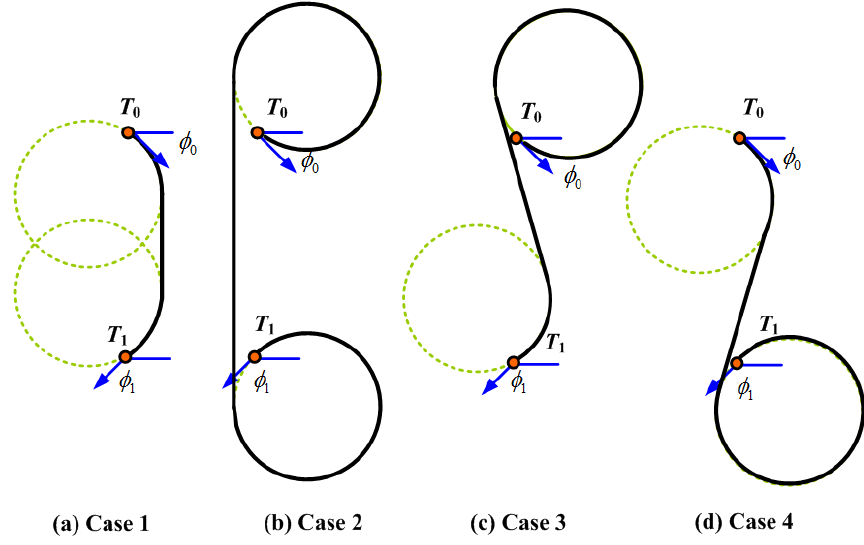
Figure 3. Four CSC types of 2D Dubins curves with φ 0 = − π /4 and φ 1 = − 3 π